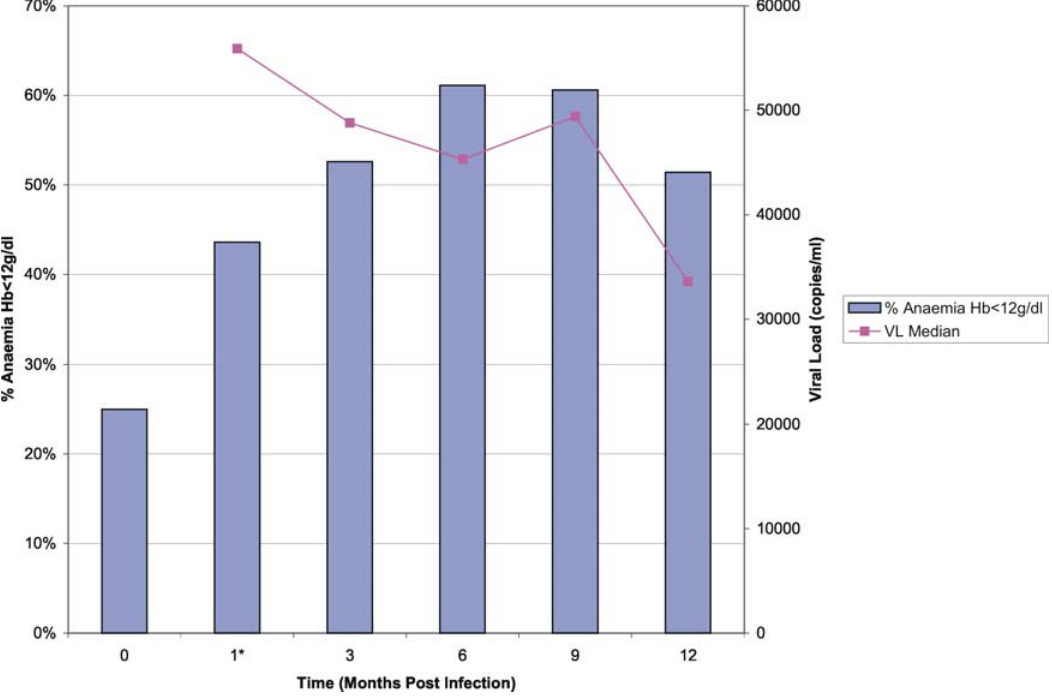
Figure 1. Prevalence of anaemia (Hb , 12g/dL) prior to (time=0) and in the months following acute HIV infection vs. median HIV viral load (copies/mL). *Note: month 1 represents the first post-infection visit which occurred at a median of 42 days post-infection (range 16-86).